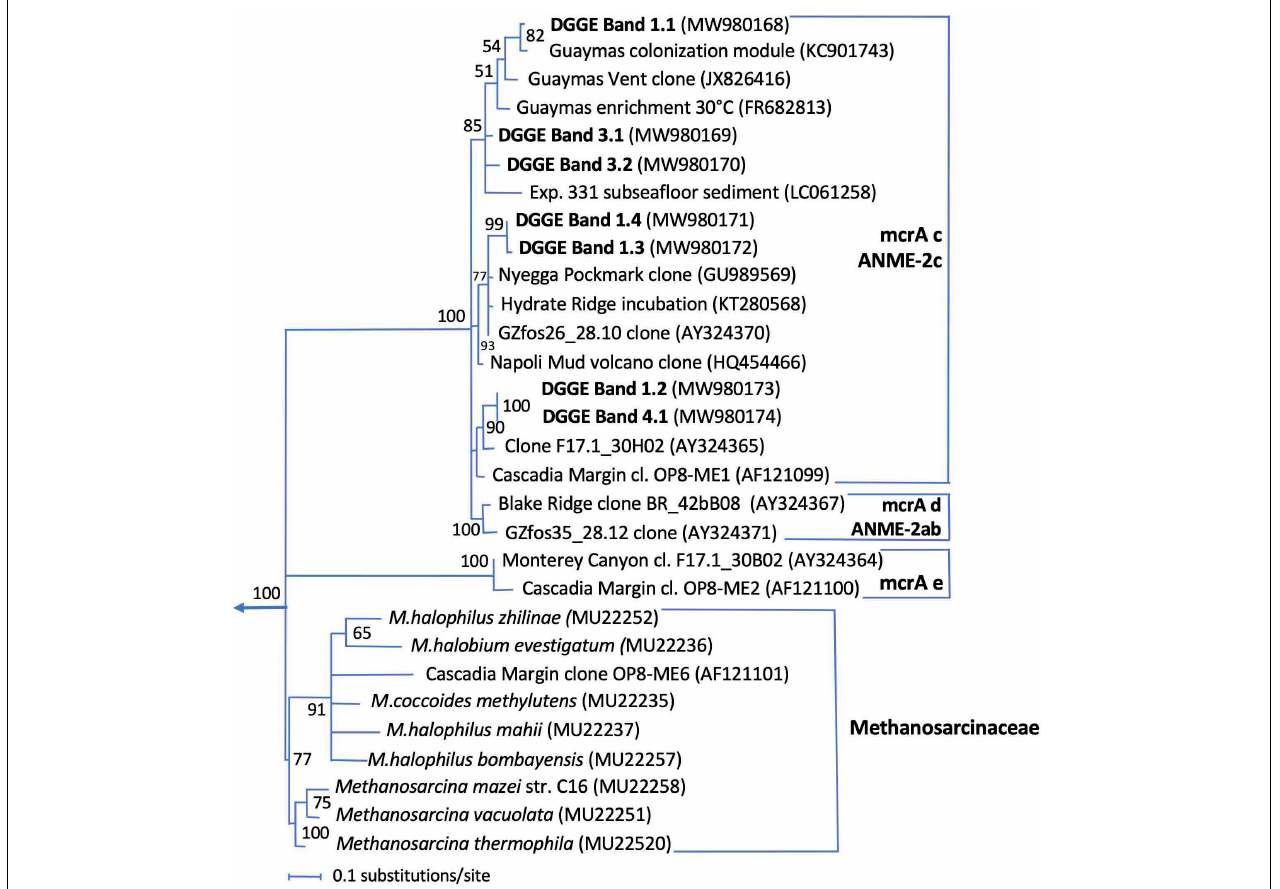
FIGURE 9 | Distance phylogeny of mcrA gene DGGE fragments, based on complete amplicon length minus primer sequences, color-coded to match the DGGE bands in Figure 8 . Bootstrap support for nodes (in%) was derived from 1000 iterations.